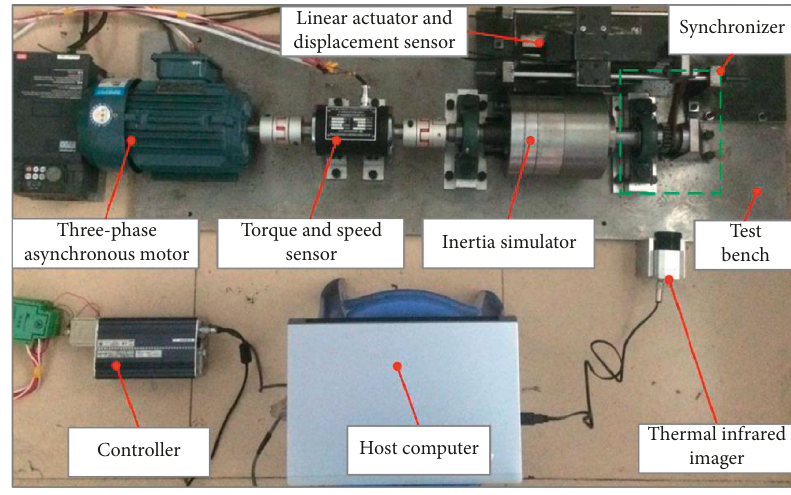
Figure 4: Schematic of experimental setup. Table 2: Specification parameters.